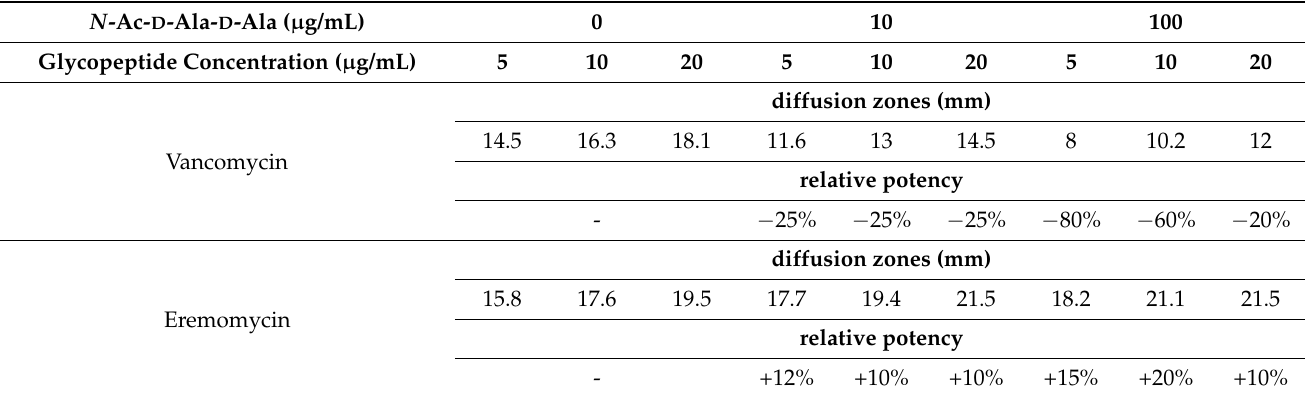
Table 2. Antibacterial activities of glycopeptides as influenced by the N -Ac- D -Ala- D -Ala dipeptide ligand (disk diffusion method) and relative potency against the Enterococcus faecalis 9 strain. N -Ac- D -Ala- D -Ala ( µ g/mL) 0 Glycopeptide Concentration ( µ